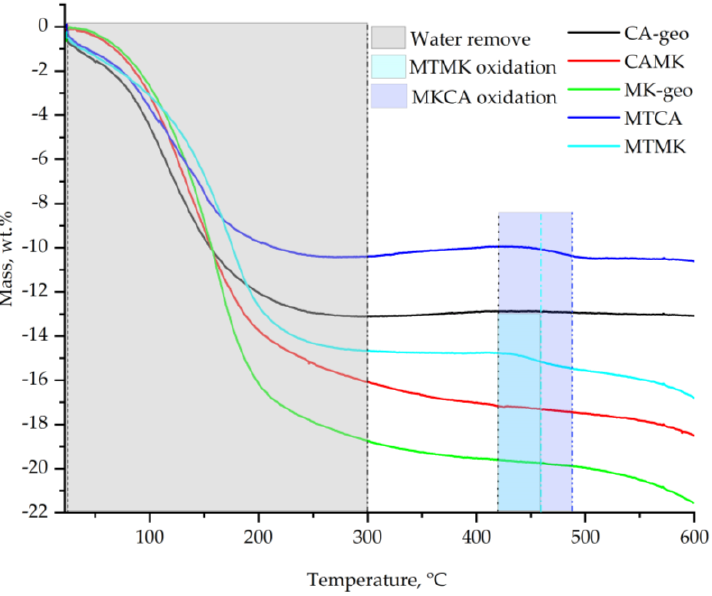
Figure 7. TGA plots of the studied